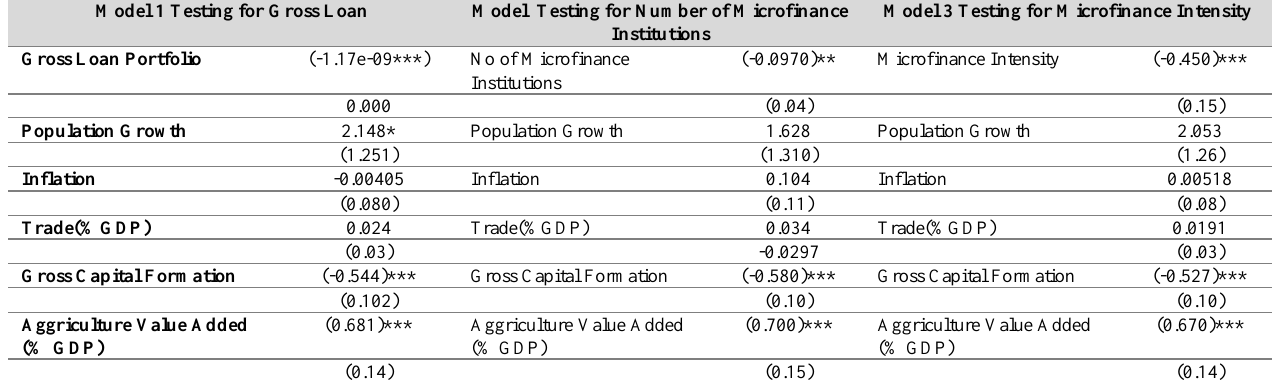
Estimated results of the Model at Poverty headcount ratio $